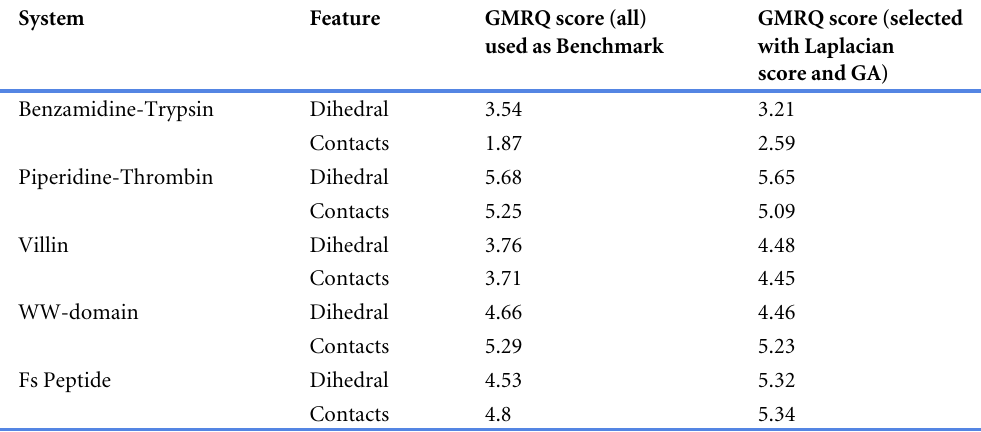
Table 2 Comparison between GMRQ score of different features and the efficiency of MSM improved with feature selection using Laplacian score and GA.